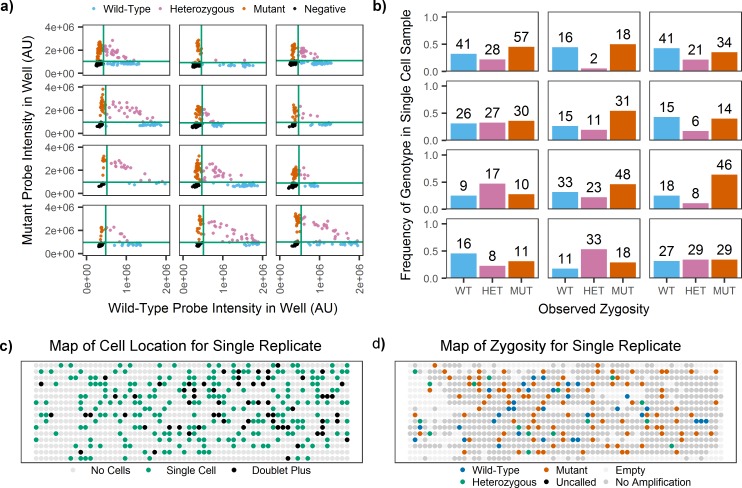
Single-cell genotyping results.(a) Scatterplots for each SD chip replicate containing OCI-AML3 cells are shown as 12 panels. The fluorescence intensity in the mutant probe channel is plotted vs. the wild-type channel intensity for single-cell containing wells. Thresholds in each channel (green) separate single-cell wells into mutant, heterozygous, wild-type, or false negative (FN). (b) For the same twelve SD chip replicates, bar plots show the frequency of single cells in the population that were assigned as wild-type, heterozygous, or mutant. (c) A representative map of wells in a single replicate shows the results from cell imaging for each well. Each dot represents one well of the device, which are categorized as having no cells, a single cell, or multiple cells (doublet+). (d) For the same array, a map of zygosity shows the location of wells categorized as wild-type, heterozygous, mutant, empty of aqueous solution (Empty), no amplification probe fluorescence (NonAmp), or having positive amplification probe fluorescence but negative allele-specific probe fluorescence (UNCALLED).